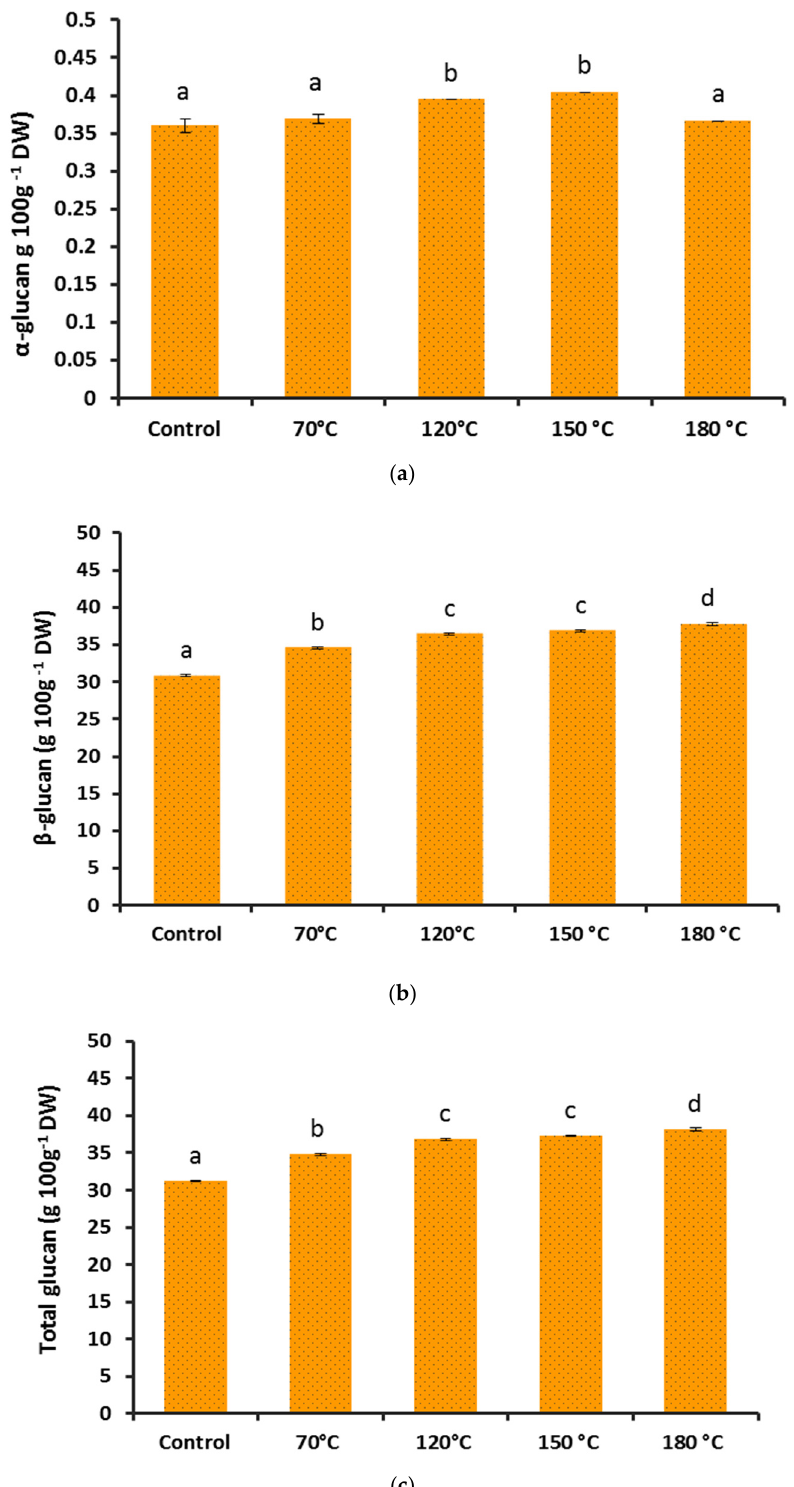
Figure 4. The effect of heat treatment on G. lingzhi ’s basidiocarp α -glucan ( a ), β -glucan ( b ) and total glucan ( c ) contents ( mean ± StDev). Different letters are for statistically different values (Games- Howell’s post hoc test, p < 0.05).